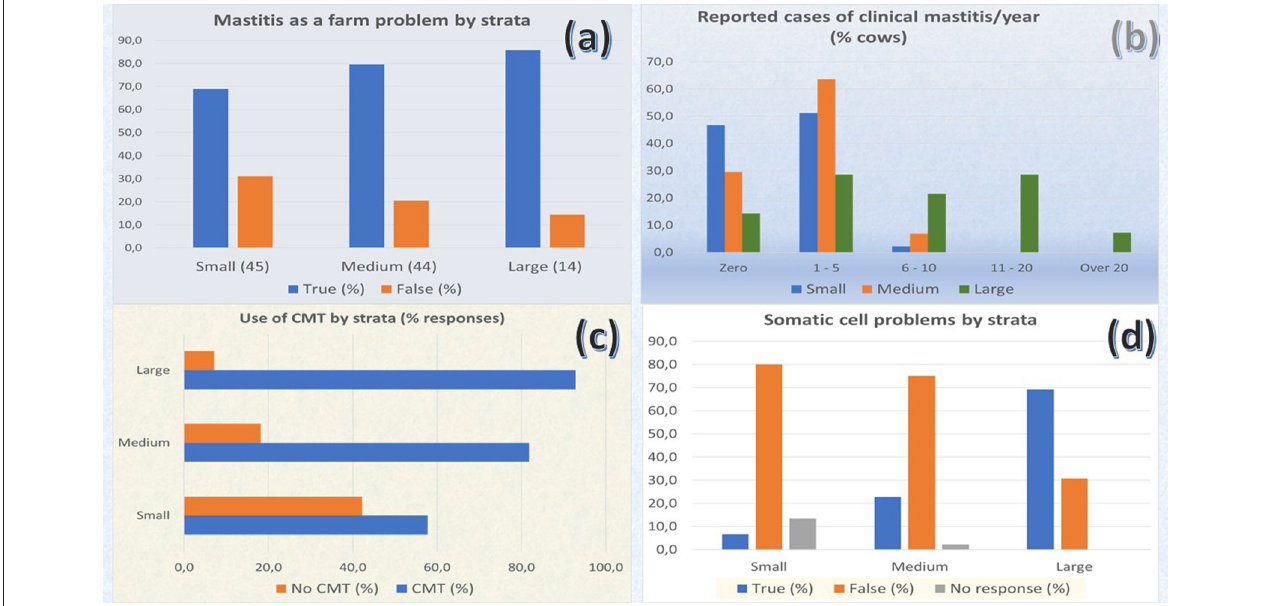
FIGURE 2 | Producer perceptions about mastitis from questionnaire survey (n:103). Frequency of percentage of answers by farm strata (a) Mastitis as a problem in their farms. (b) Occurrence of clinical mastitis. (c) Use of CMT at farm. (d) Buyers complaining about SCC in milk.